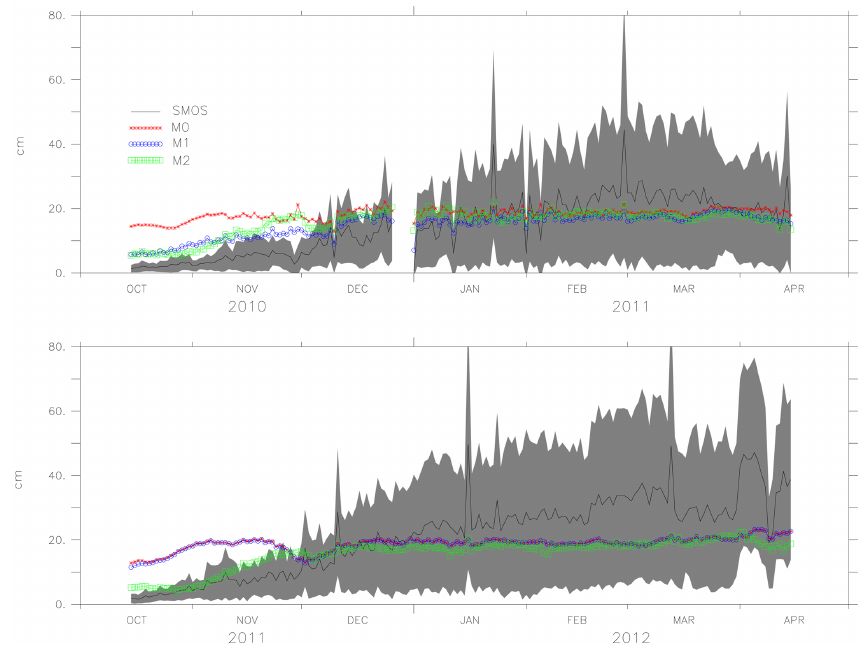
Figure 10. The ice thickness from the models M0, M1, M2 and observation (SMOS ice thickness) and the observation uncertainty (shaded grey) for SMOS ice thickness less than 30cm (2010–2012).